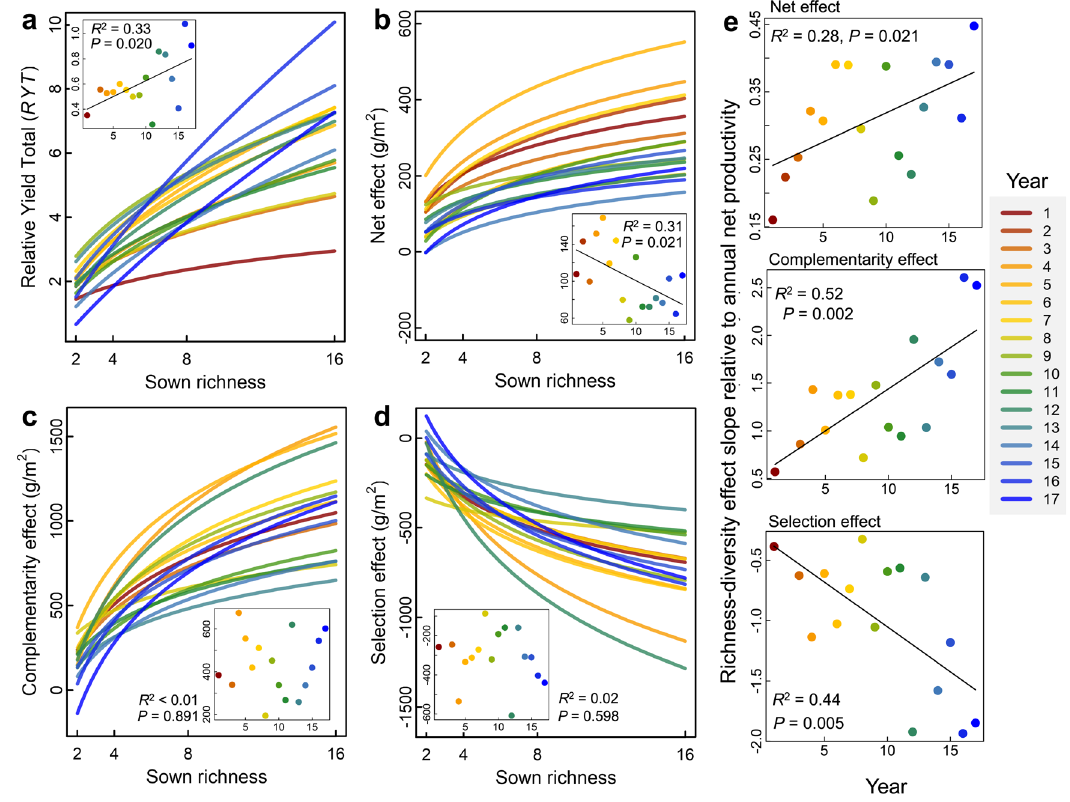
Fig. 2 | Effects of sown species richness on the annual biodiversity effects. The effectsofrichnessonthe a relativeyieldtotal(RYT), b net, c complementarity,and d selectionbiodiversityeffectsareshownforeachyear(1=2003,17=2019).Panels a – d showtheregressiontrendoftheeffectofsownrichnessforeachofthe17years ( fi tting the dependent variable against log species richness. The RYT was also log- transformed prior to analysis. Linear regression relationships are shown on the original scale and the signi fi cance for a difference from 0 was two-sided). Inset is